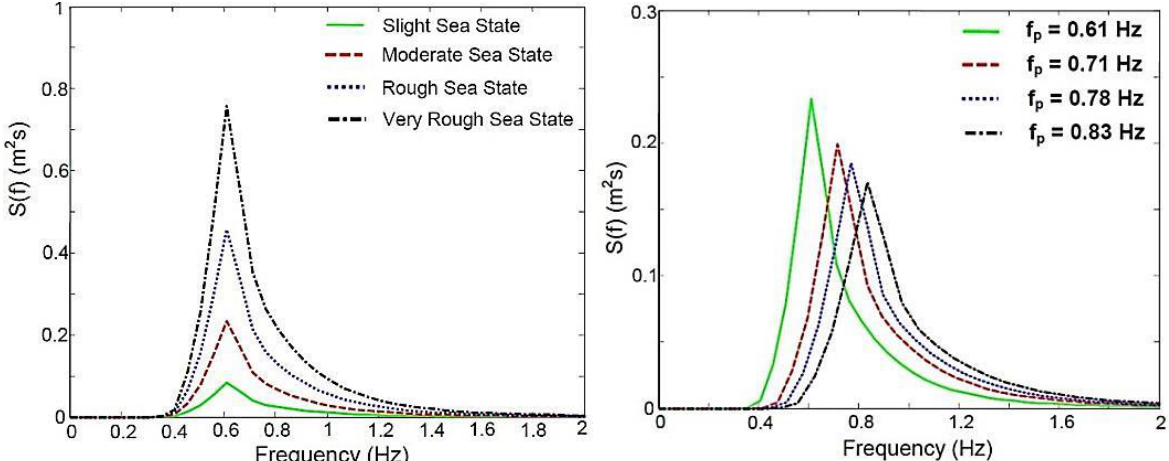
Figure 11. JONSWAP energy spectrum unidirectional long-crested random waves with different: significant wave height ( left ); peak frequency ( right ).